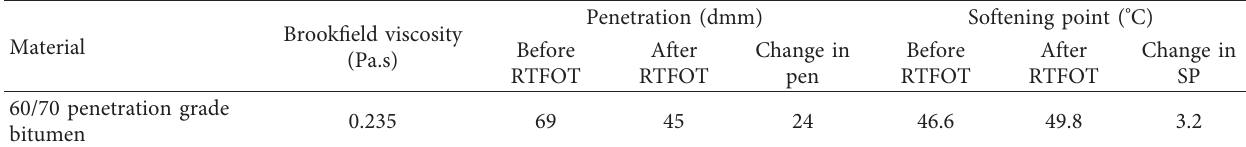
Table 9: Penetration and softening point before and after